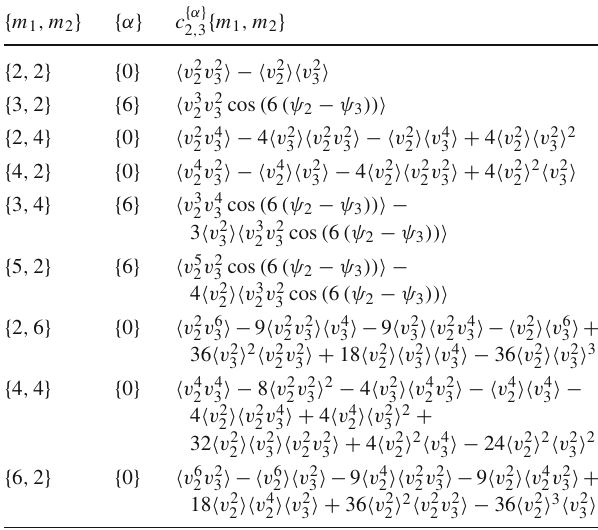
Table 4 Two-harmonic cumulants up to order